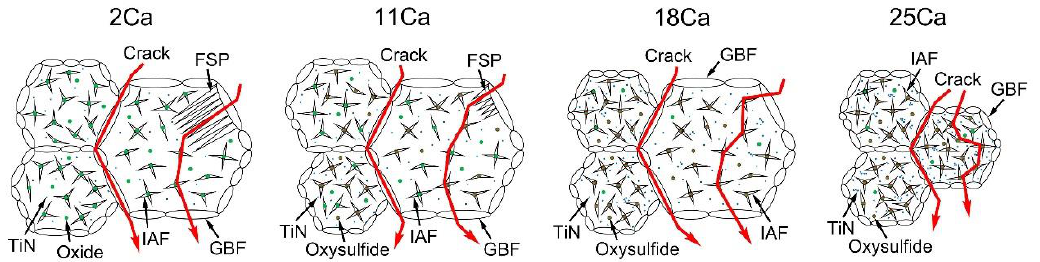
Figure 9. Schematic diagram of microstructural evolution and impact crack path of CGHAZ of the HSLA steels with the variation in the Ca content. IAF means intragranular acicular ferrite. GBF means grain boundary ferrite. FSP means ferrite side plate.